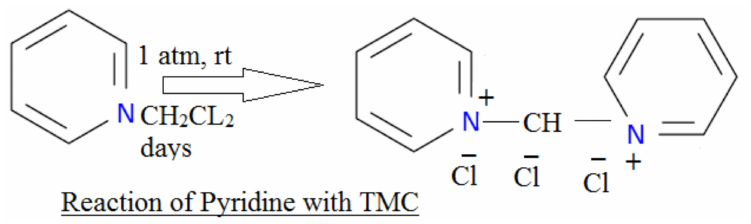
Figure 6. Representation of reaction of pyridine with TMC (choloroform).